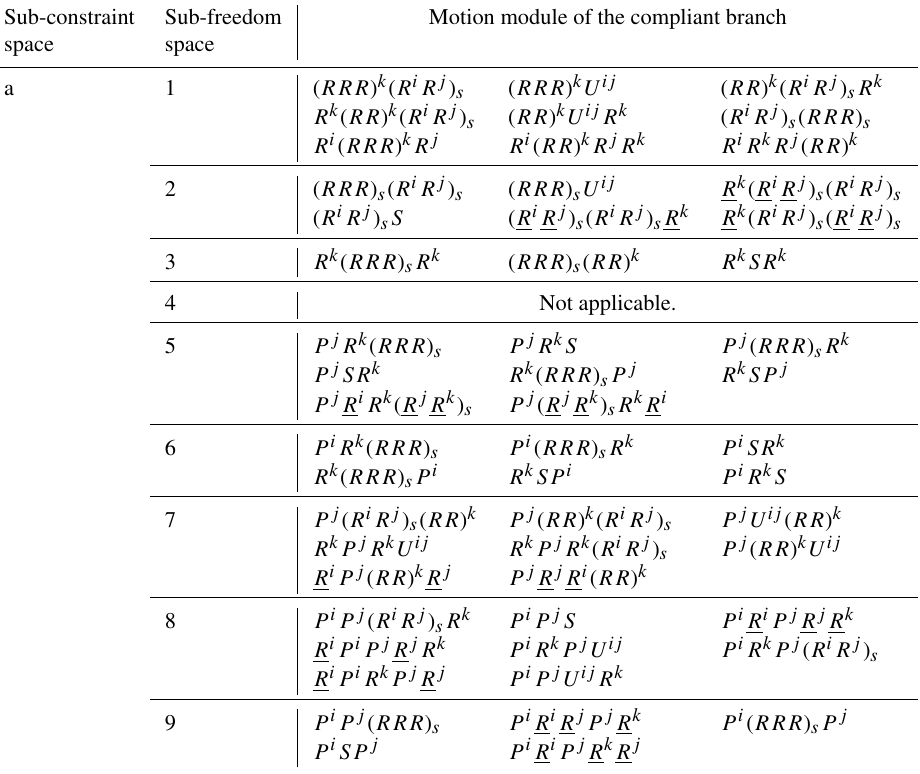
Table 4. The configurations of a compliant branch under single-force constraint. Sub-constraint Sub-freedom Motion module of the compliant branch